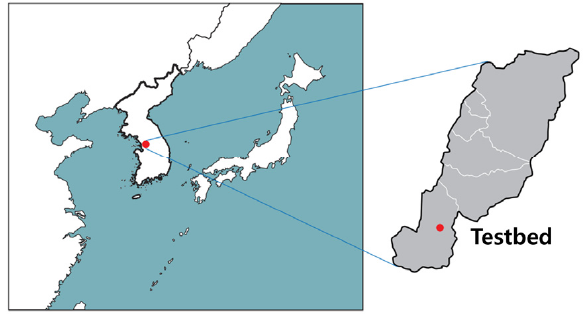
Figure 6. Location of testbed.